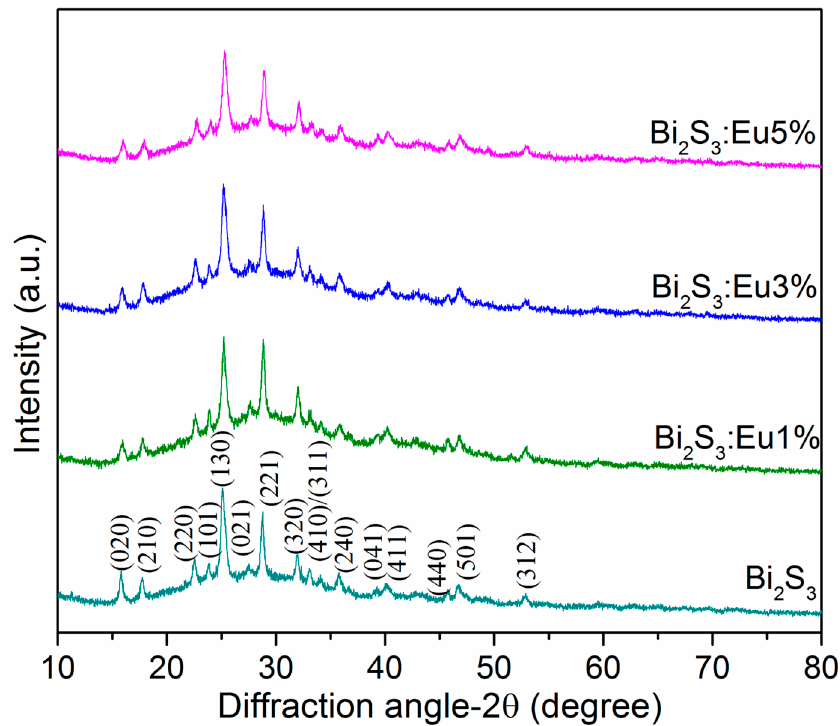
Figure 1. XRD pattern of un-doped and Eu doped Bi 2 S 3 thin films.